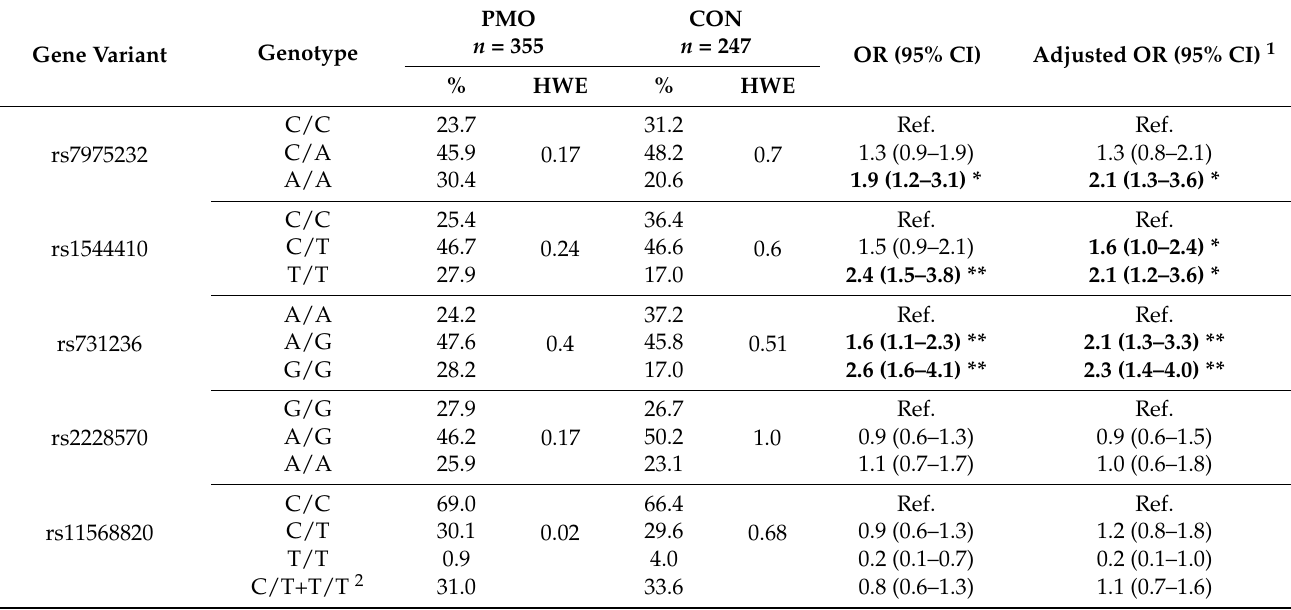
PMO, postmenopausal osteoporosis; CON, control; HWE, Hardy–Weinberg equilibrium; OR, odds ratio; CI, confidence interval; Ref., referent value; * p FDR < 0.05, ** p FDR < 0.01; 1 Adjusted by confounding factors (BMI); 2 Dominant model of inheritance used due to low minor allele frequency. The values highlighted in bold indicate a significant association. The minor allele frequencies of all analyzed SNVs were not significantly different from those taken from GnomAD data for Europeans [22]. By the analysis, the genotyping data were found to be in correspondence to the expected Hardy–Weinberg equilibrium at the